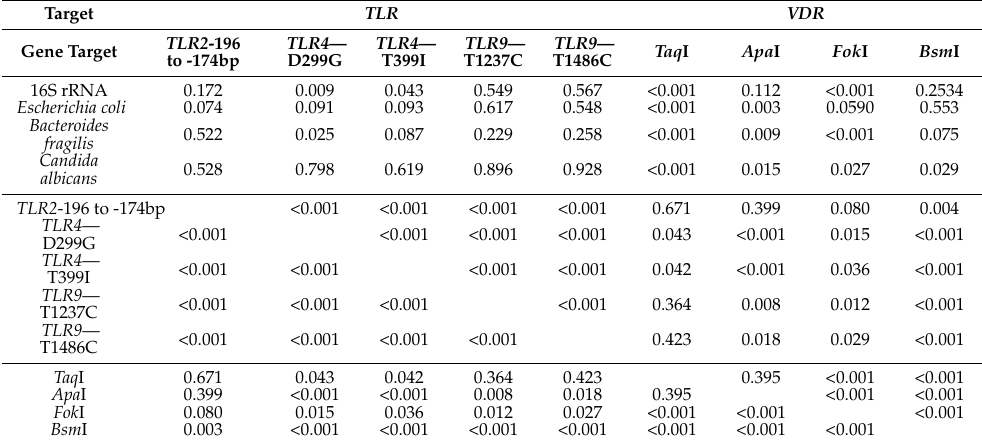
Table 4. Correlation between microbial DNA fragments, Toll-like receptor ( TLR ) and vitamin D receptor ( VDR ) polymorphisms parameters (values against each category represents p -values).